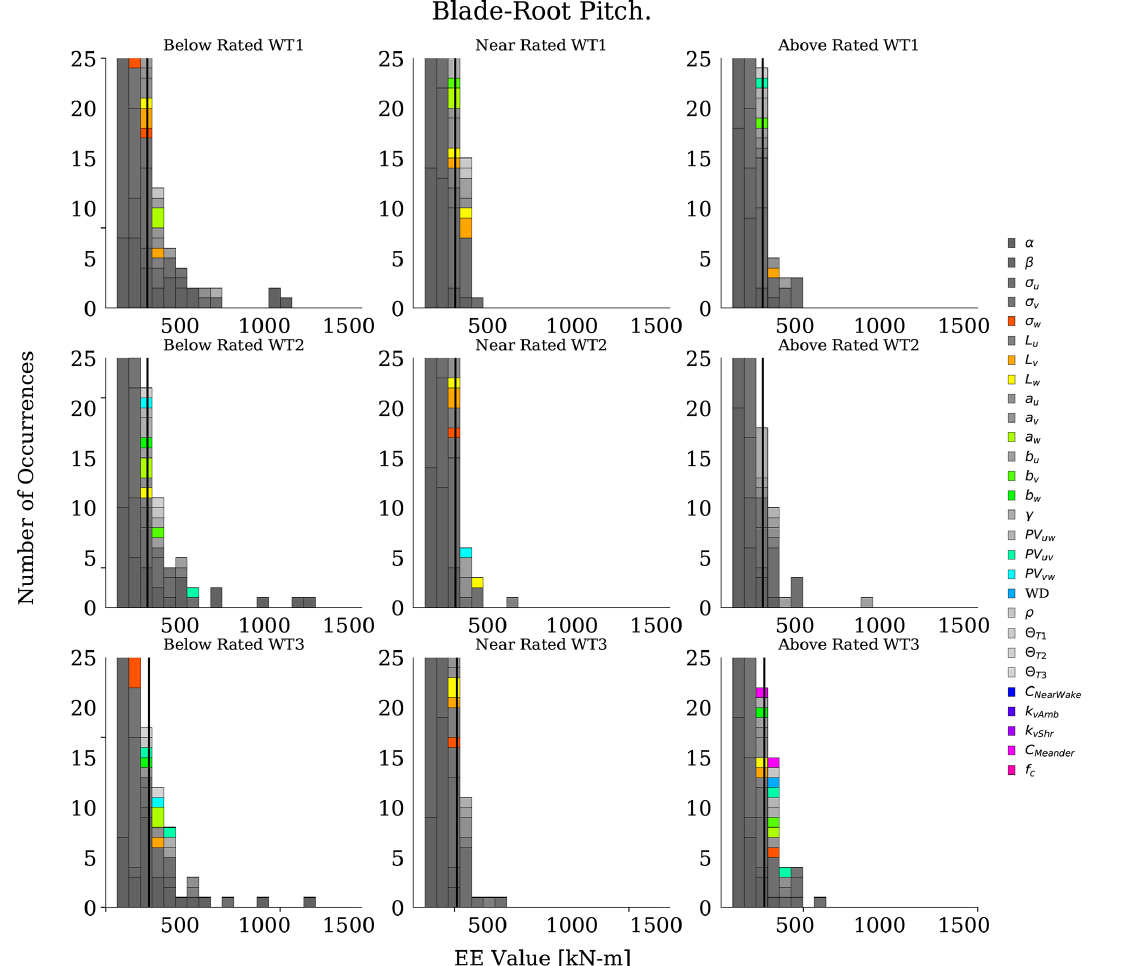
Figure 6. Histograms of ultimate load EE values for the blade-root pitching moment. Each subplot shows one wind speed bin and wind turbine and includes all input parameters. Each column of subplots corresponds to a wind speed bin, and each row of subplots corresponds to a wind turbine. The vertical lines on each plot correspond to the threshold value used to identify significant events. The y axis has been limited to focus on results contributing to significant event